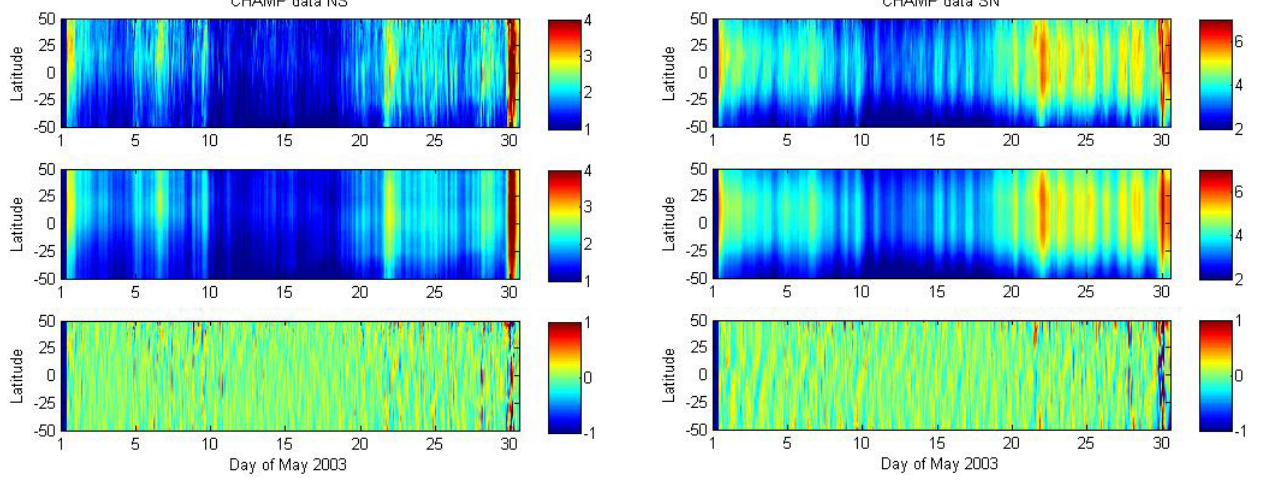
Fig. 4a. Upper panel: CHAMP/STAR density estimates along the NS orbit segments, as a function of latitude and UT time during May 2003. Remember that, in fact, altitude and latitude variations are combined in this colour plot. Middle panel: projection of the CHAMP/STAR density data on the first singular vector (see text for further explanation). Lower panels: residuals, i.e. differences between the CHAMP/STAR densities and their projection on the first sin- gular vector. During May 2003 and along the NS orbit segments, LT at the satellite position varies from 05:40 a.m. to 02:55 a.m. (see Fig. 1). For the three panels, the density variations are displayed using the colour scale displayed on the right; they are expressed in terms of 10 − 12 kgm − 3 units.